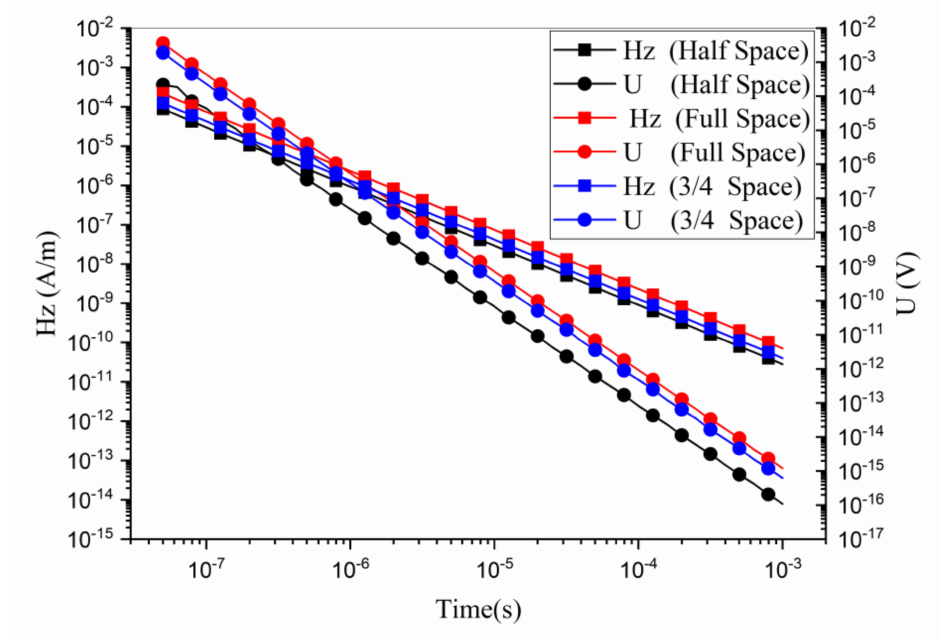
Figure 5. Variation diagram of magnetic field and induced voltage in the Z direction of the center point of three space state models under the condition of uniform